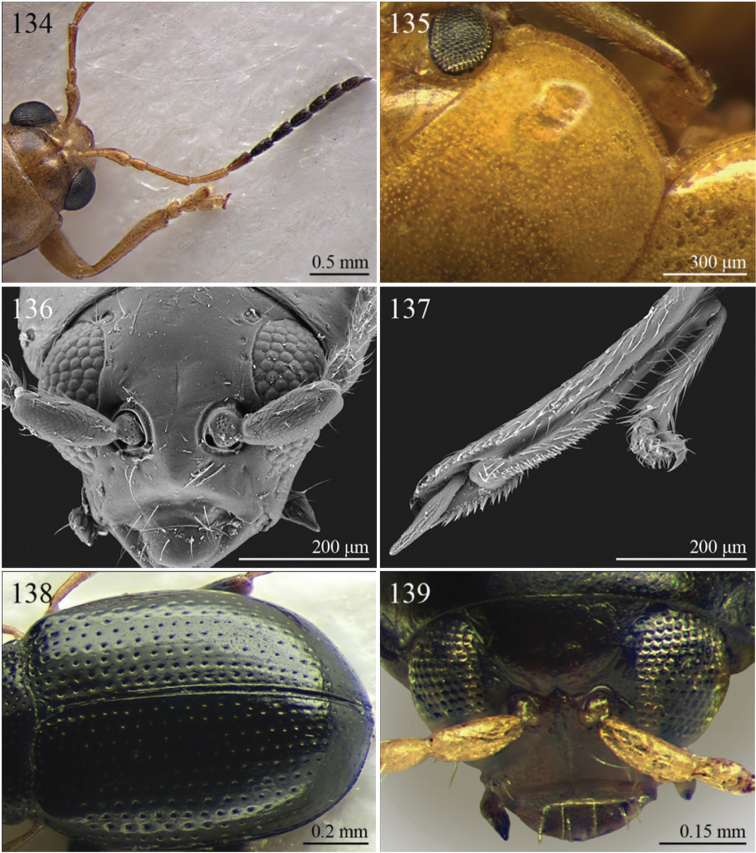
Morphological characters. 134
Bangalaltica antennalis Bechyné, head and right antenna in dorsal view 135
Bechuana nigripes Scherer, sublateral depression on pronotum 136
Bechynella pallens (Bechyné), head in frontal view 137 Ditto, hind tibia and metatarsus 138
Bezdekaltica socotrana Döberl, elytra in dorsal view 139
Bikasha fortipunctata Maulik, head in frontal view.